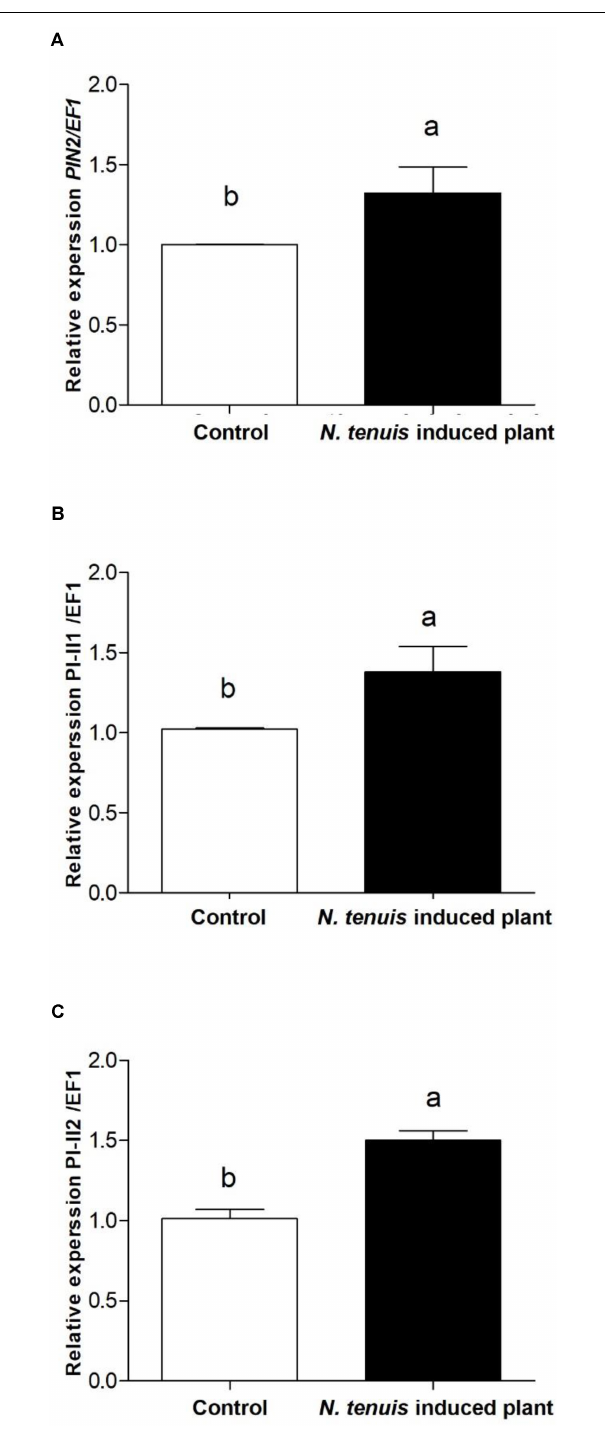
FIGURE 4 | Transcriptional response of the defensive gene PIN2, a JA-responsive gene (A) , and two plant Proteinase Inhibitor (PI-II1 and PI-II2 ) markers (B,C) , in control tomato plants with comparison to plants pre-exposed to N. tenuis for 24 h. Data is presented as the mean of eight independent analyses of transcript expression relative to the constitutive EF1 gene ± SE ( n = 8). Bars with different letters are significantly different ( t -test; P <